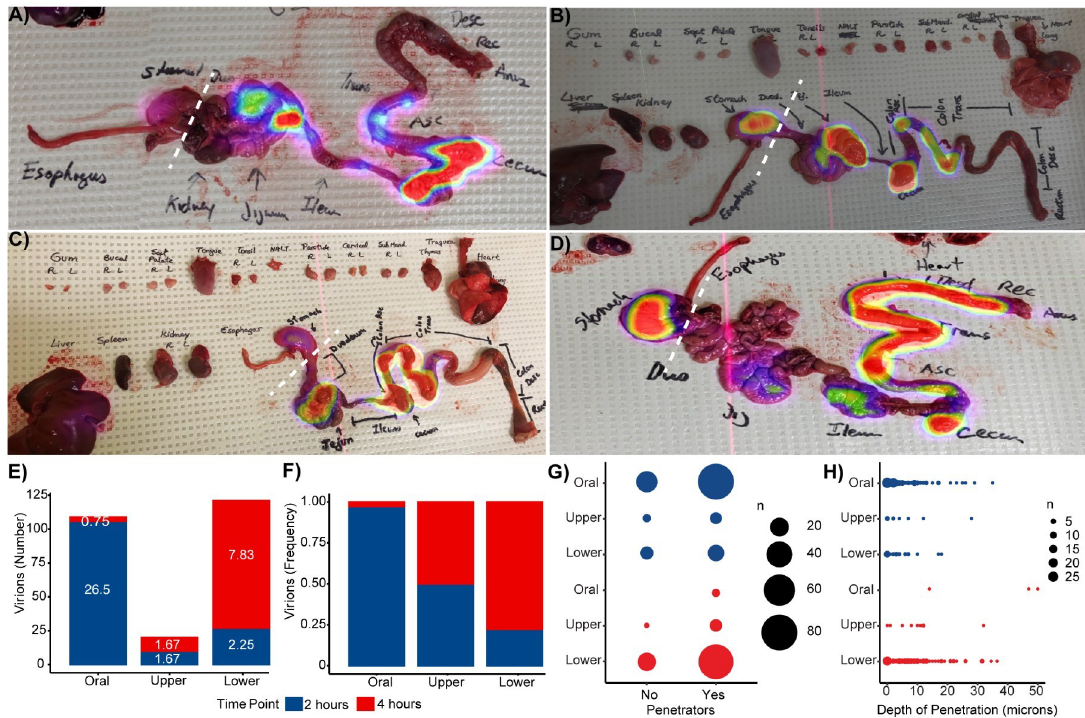
Fig 2. HIV virions distribute throughout and penetrate the mucosal epithelium of the entire GI tract four hours post-oral challenge. Whole GI tracts were excised and imaged by PET at two- and four-hours following necropsy. PET images overlayed on photographs allow for visualization of radioactivity throughout the GI tract at two hours (A-B) and four hours (C-D) post challenge. White dotted lines depict where the GI tracts were dichotomized into upper (esophagus and stomach) and lower (small and large intestines) regions. Quantification of virions and viral penetration in the oral cavity, upper GI tract, and lower GI tract mucosa two and four hours after oral viral challenge. E) Total number of virions counted in images. Means of the virion count per group shown on stacked bars in white numbers. F) Frequency of total virions counted in each specific anatomic site; frequencies obtained by combining the virions in both animals at each time point, respectively. G) Quantification of the number of penetrating virions. Circle area represents the number of virions. H) Virion penetration depth in microns. Each virion depth was truncated to integer numbers for representation purposes. Circle area represents the number of virions with the same depth value. Blue: two hours, Red: four